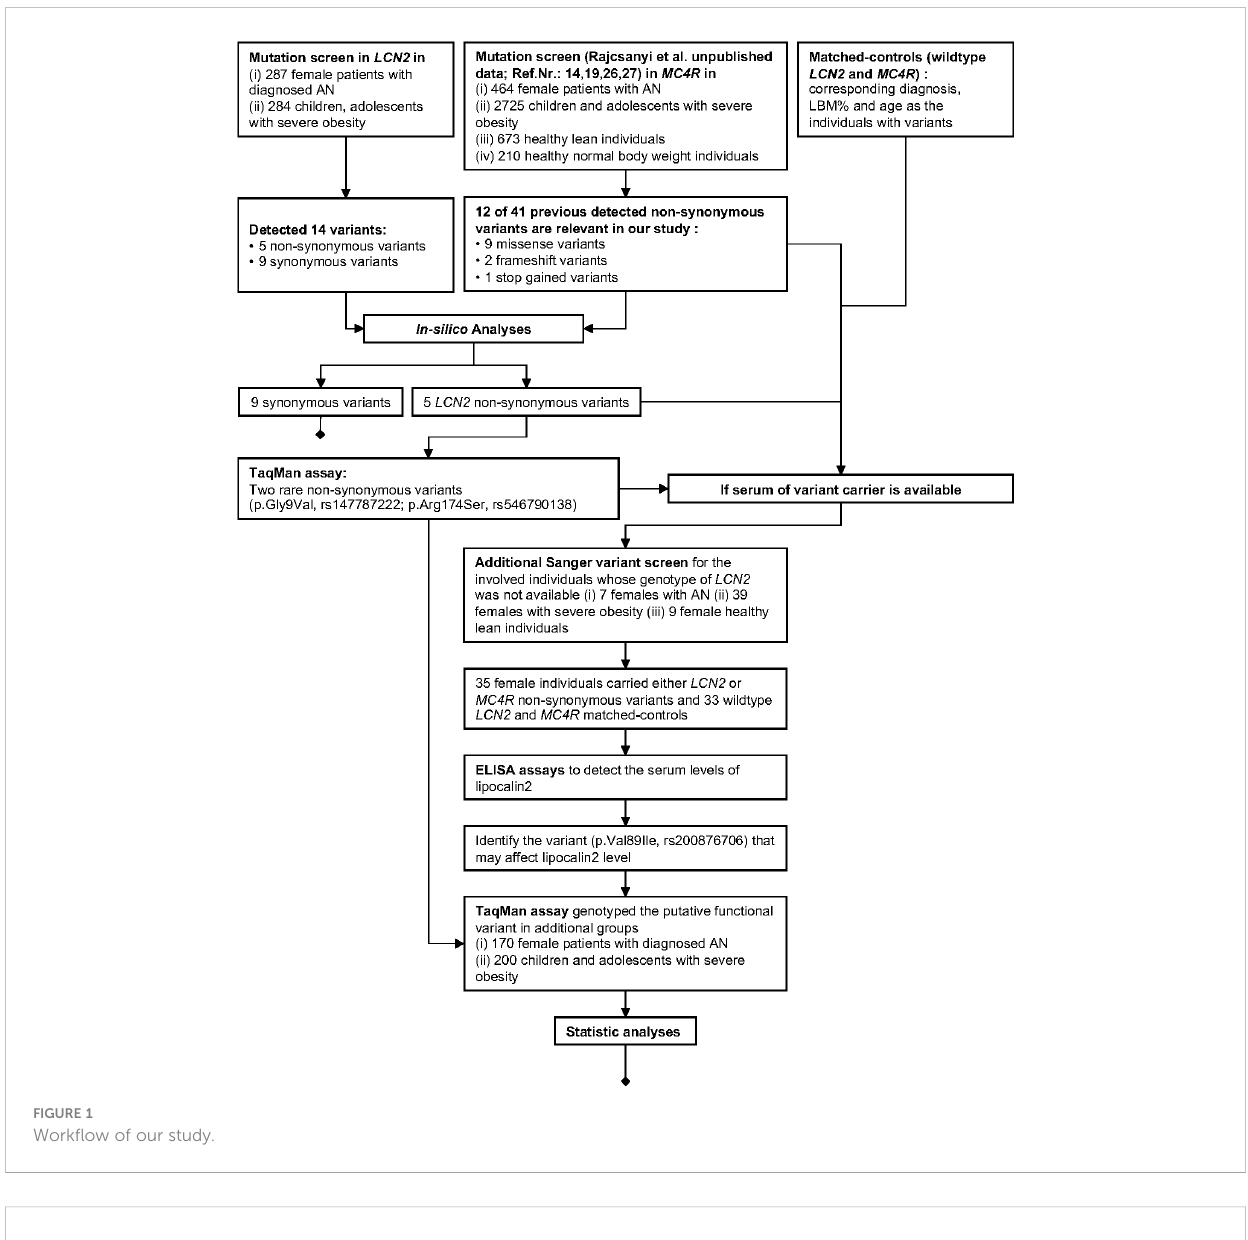
FIGURE 1 Work fl ow of our study.